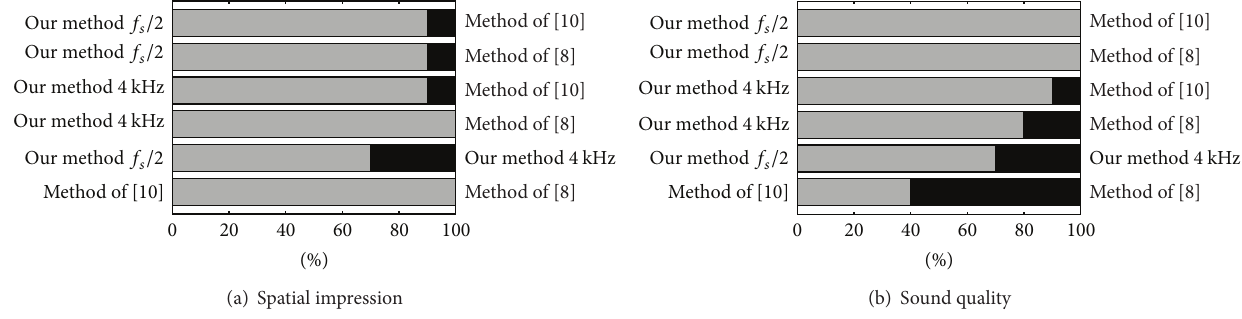
Figure 16: Preference listening test results for the speech recording with binaural reproduction.